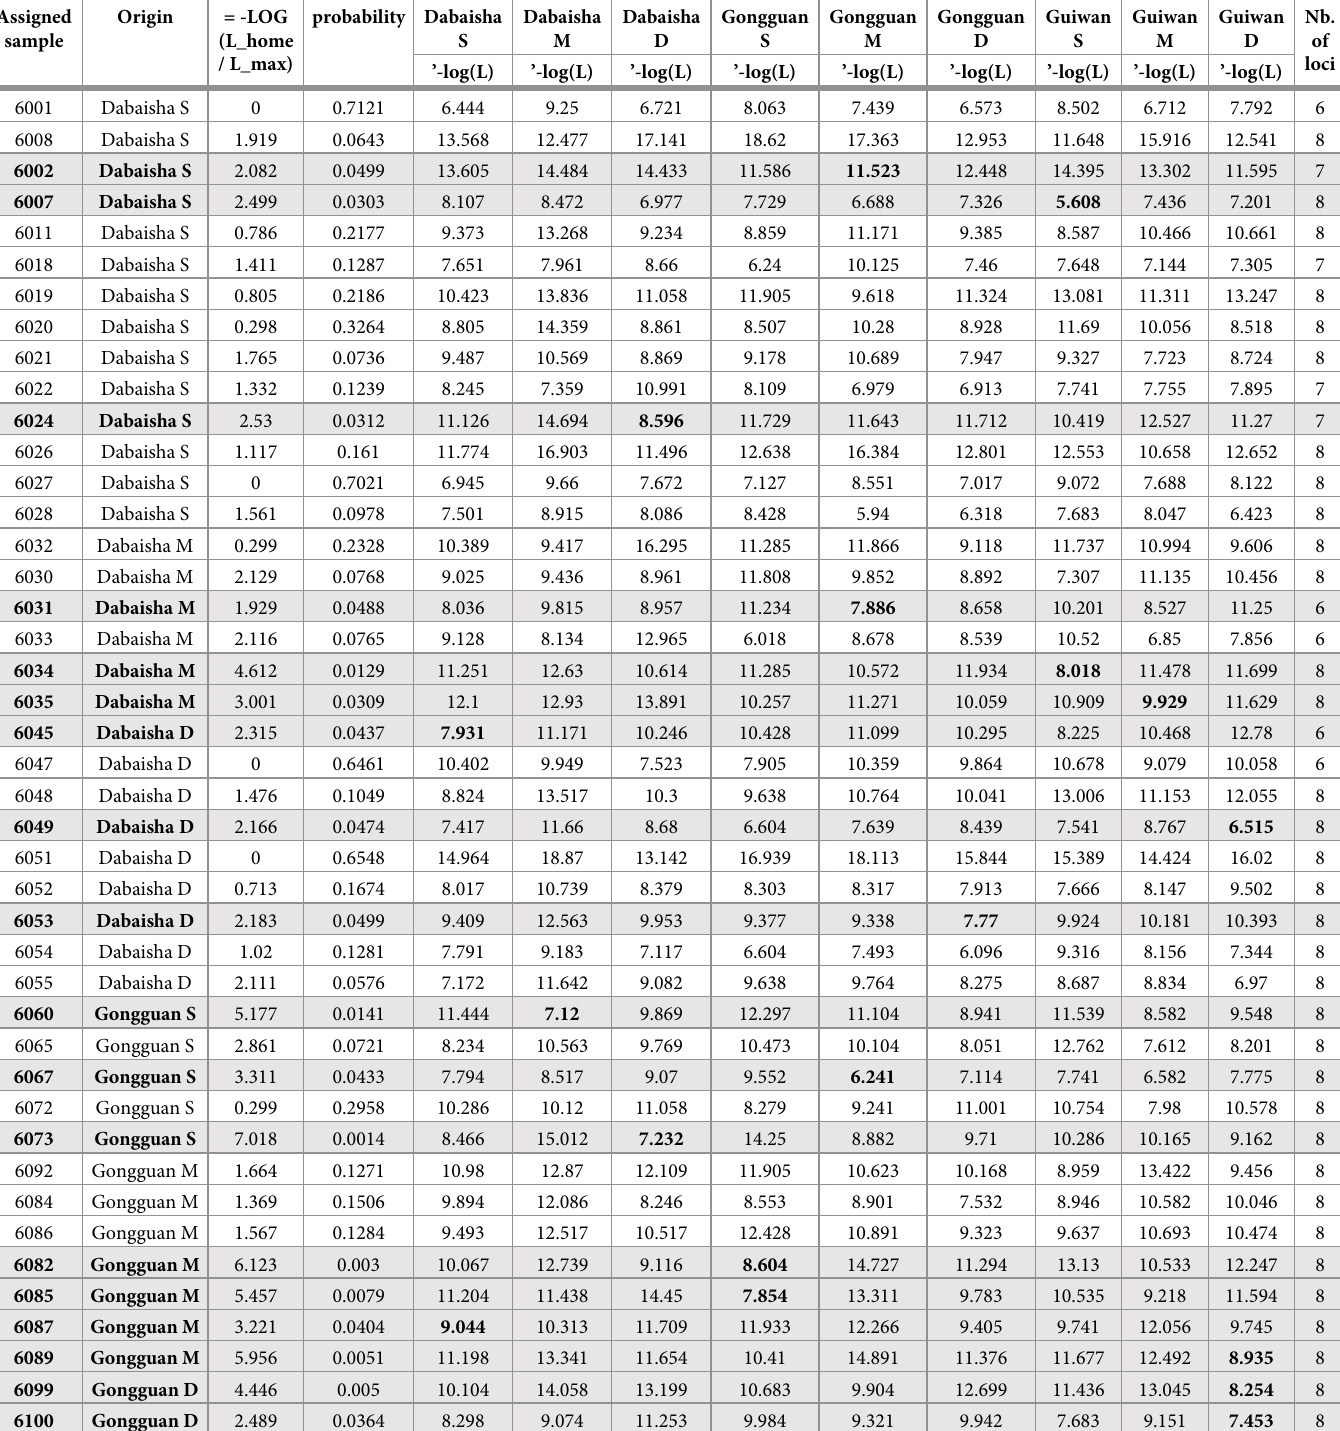
Table 4. Detection of potential new migrant. For each specimen (Assigned sample) from the location where it was sampled (Origin) the table gives the likelihood (-log (L home /L max ) of this specimen to be a new migrant with its respective probability p < α and the likelihood of originating from another location (-log(L)). Shaded lines high- light potential new migrants their possible location of origin in bold . Number of loci (Nb. of loci) are the loci used for calculations (loci with missing data were not included into the